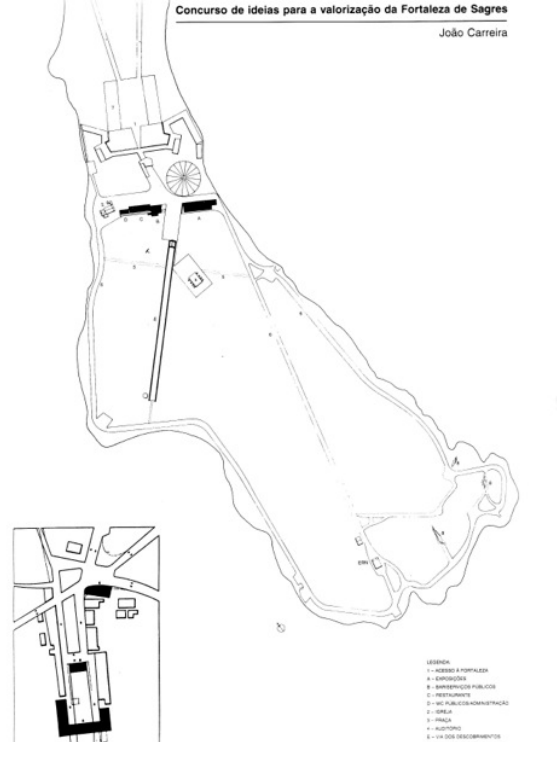
FIGURE 19 | J. Carreira, Ideas Competition for the valorization of Sagres Fortress, 1988.